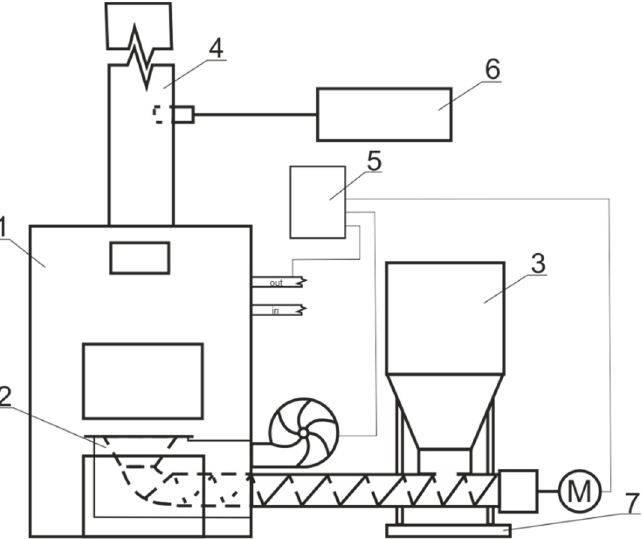
Figure 1. Scheme of boiler stand: 1—test boiler, 2—furnace, 3—pellet reservoir, 4—chimney, 5—boiler controller, 6—exhaust gas analyzer, 7—scales.